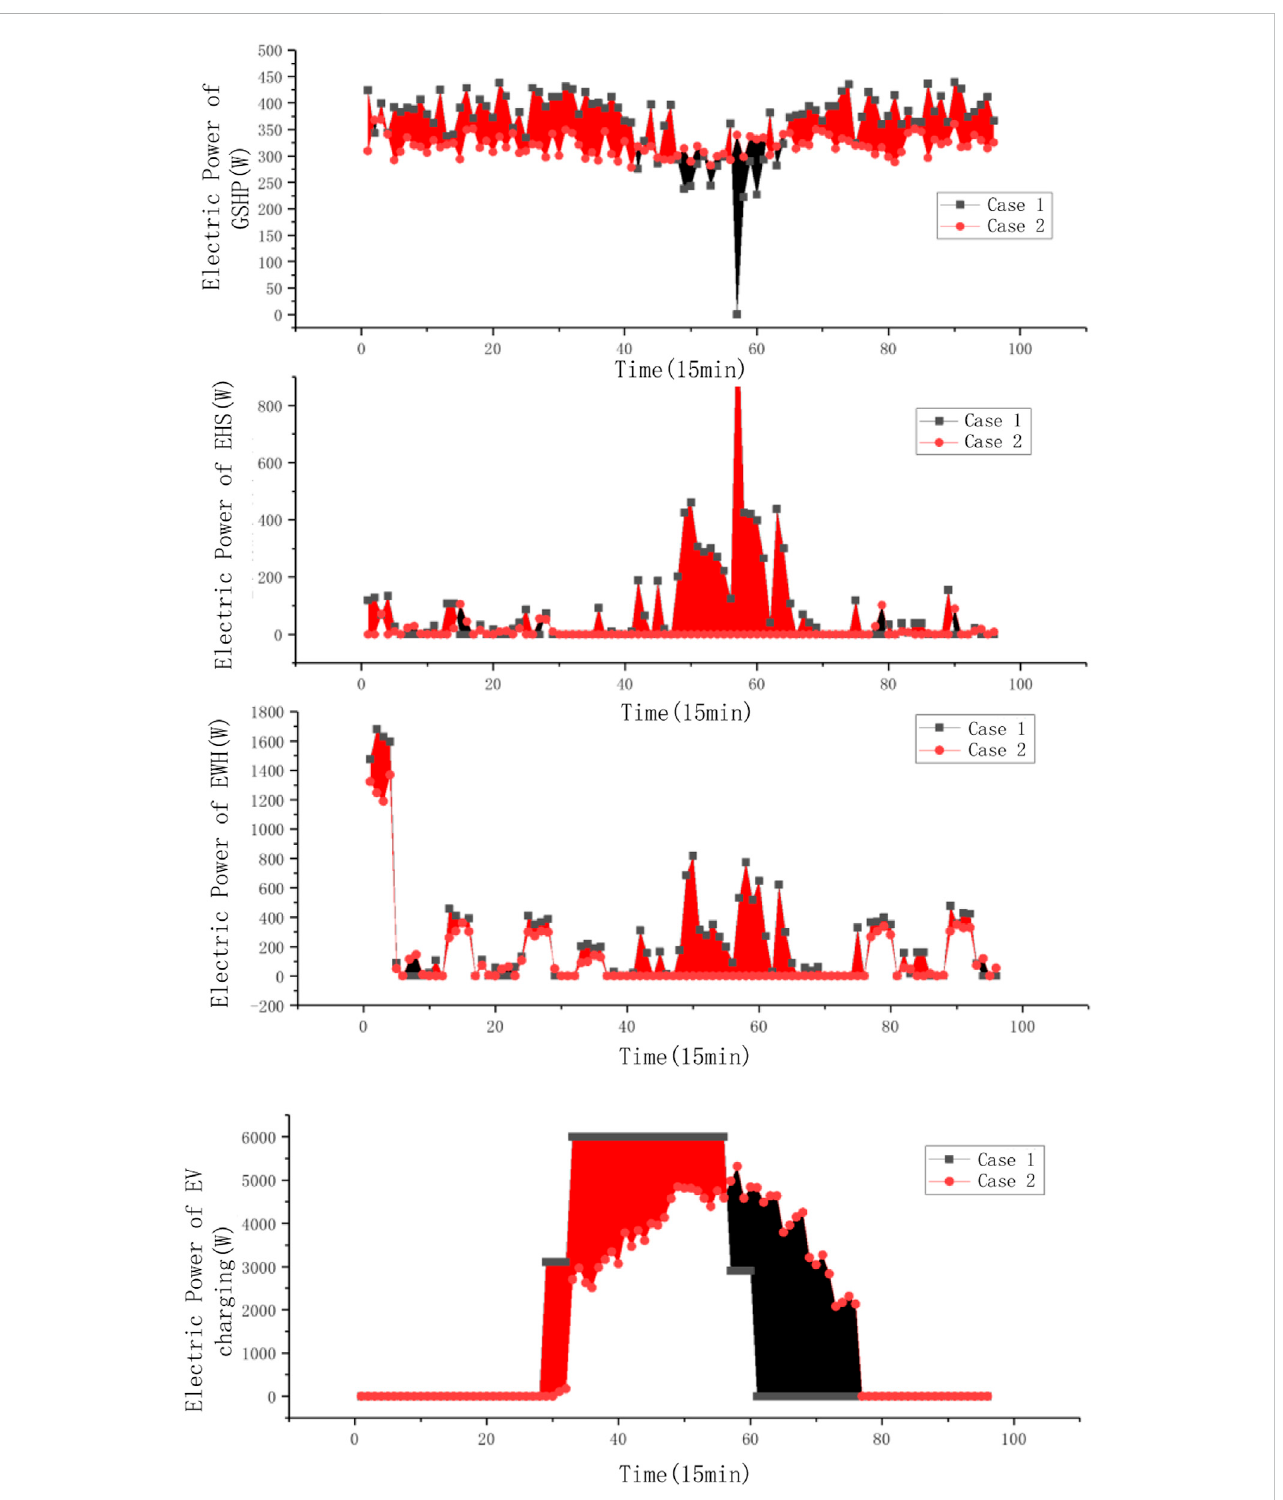
FIGURE 8 Dispatching and operation of MEHLs in two cases in the RT